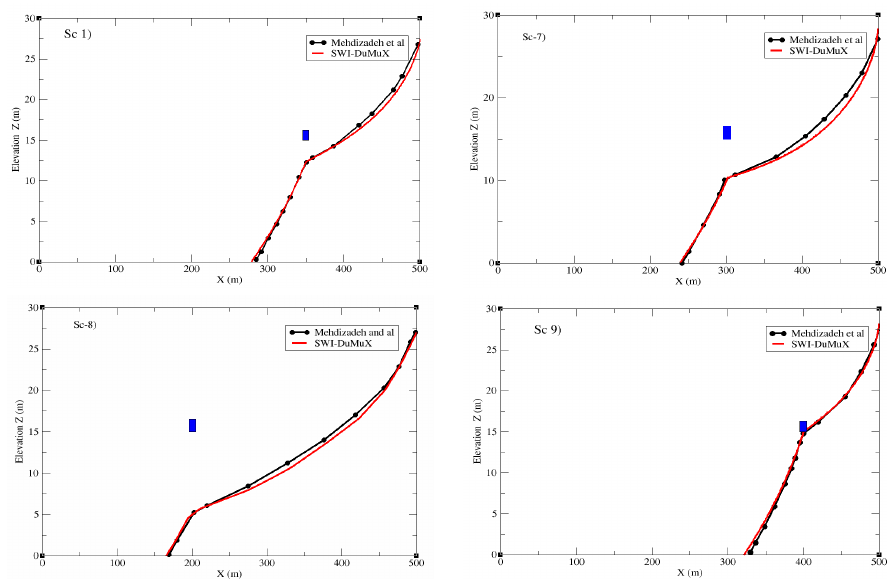
Figure 6. Evolution of the salt front for the Sc-1, Sc-7, Sc-8 and Sc-9